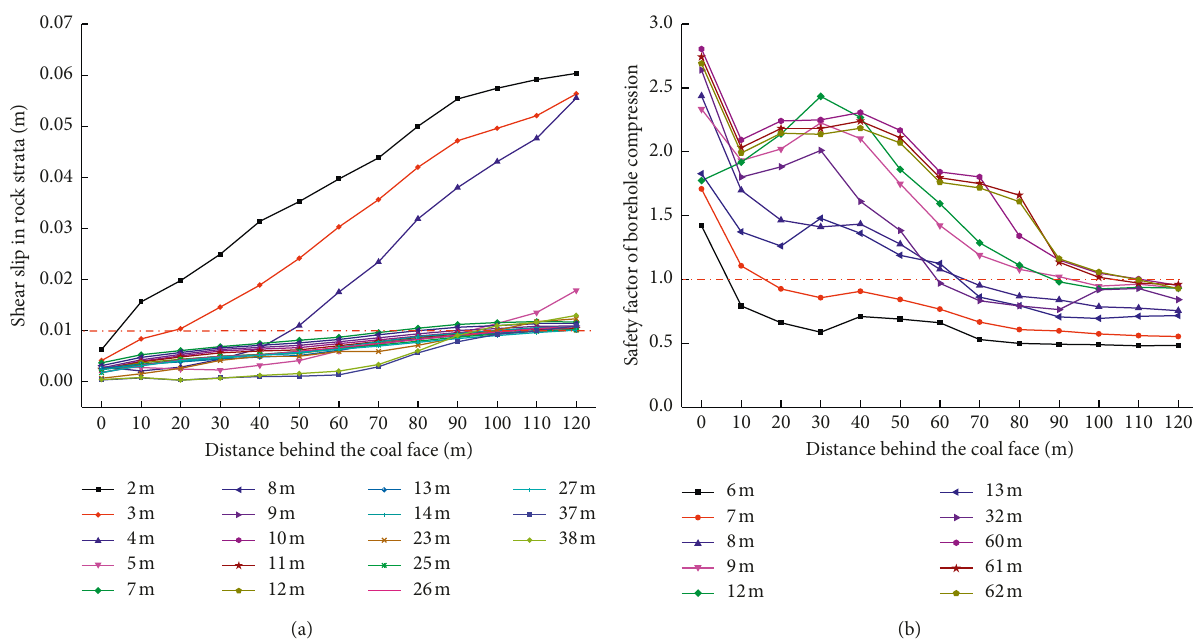
Figure 11: Evolution laws for the stability of the borehole with advance of the coal face. (a) Evolution of the dangerous location and shear slip of the borehole with advance of the coal face. (b) Evolution of the dangerous location and safety factor of borehole compressional failure with advance of the coal face.